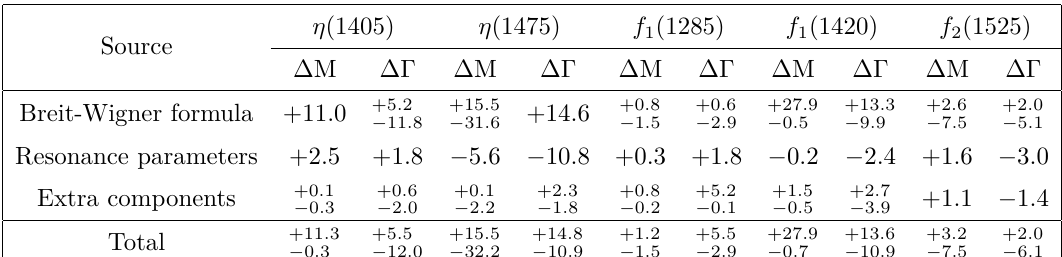
Table 6 . Summary of the systematic uncertainty sources and their corresponding contributions to the systematic uncertainties in masses (MeV /c 2 ) and widths (MeV) of η (1405) , η (1475) , f f 1 (1420) and f 2 (1525) , denoted as ∆ M and ∆Γ , respectively.